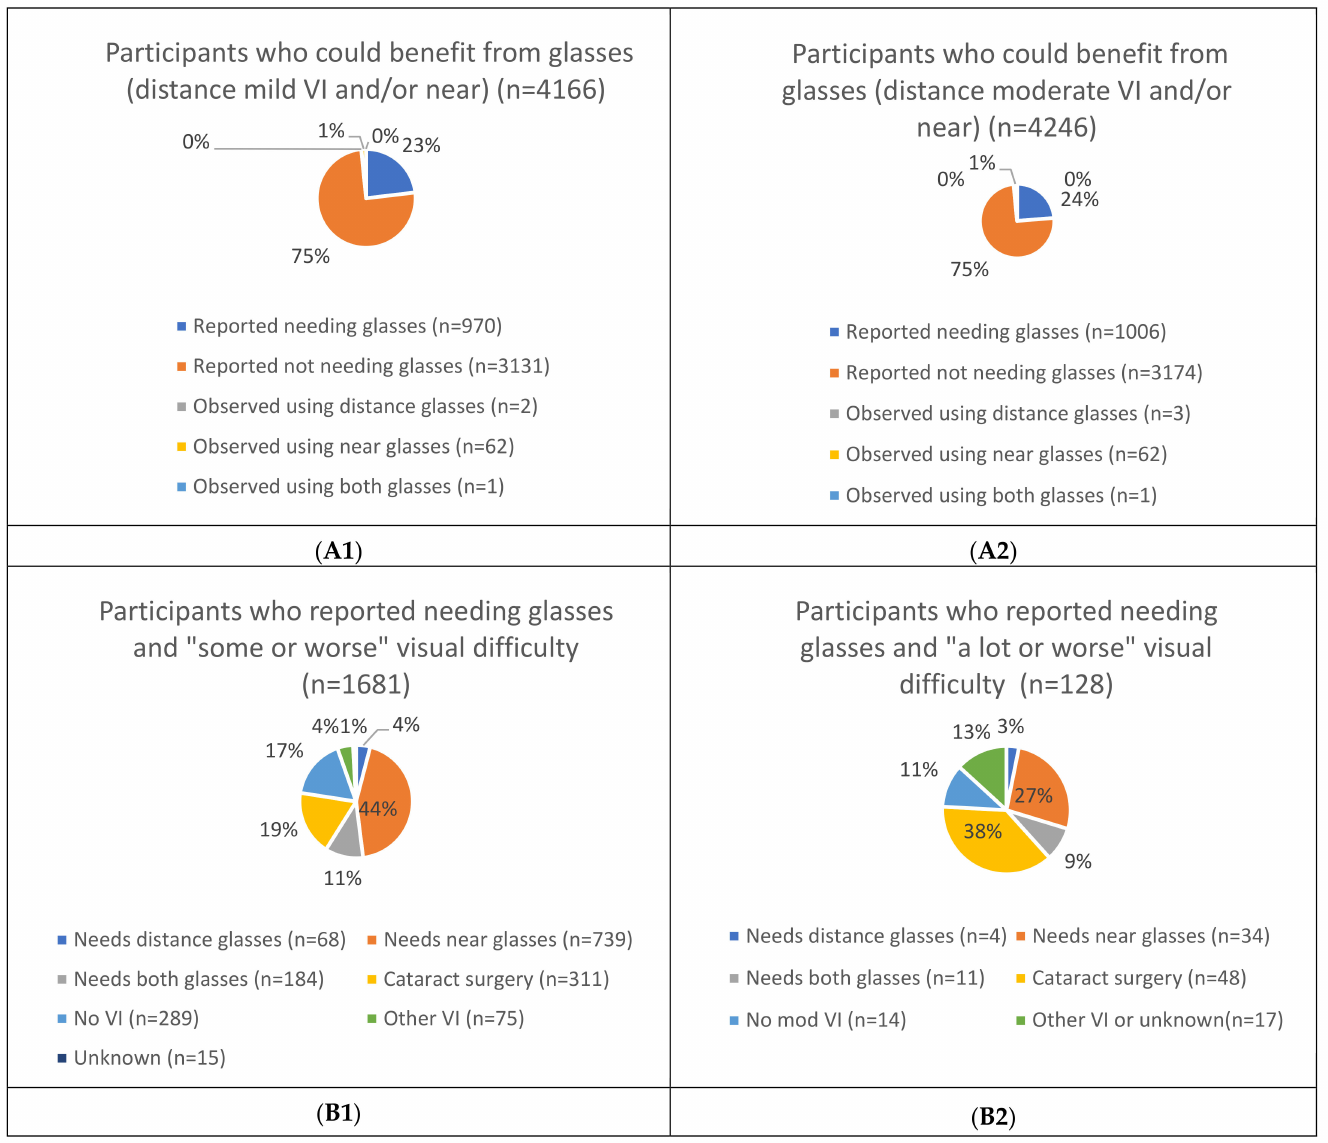
Figure 1. Comparing reported versus clinical impairment assessment unmet/undermet need for near and/or distance glasses (mild vs. moderate vision impairment (VI)). ( A1 ) : Participants who could benefit from glasses (distance mild VI and/or near) (n = 4166), ( A2 ): Participants who could benefit from glasses (distance moderate VI and/or near) (n = 4246), ( B1 ): Participants who reported needing glasses and “some or worse” visual difficulty (n = 1681), ( B2 ): Participants who reported needing glasses and “a lot or worse” visual worse difficulty (n =